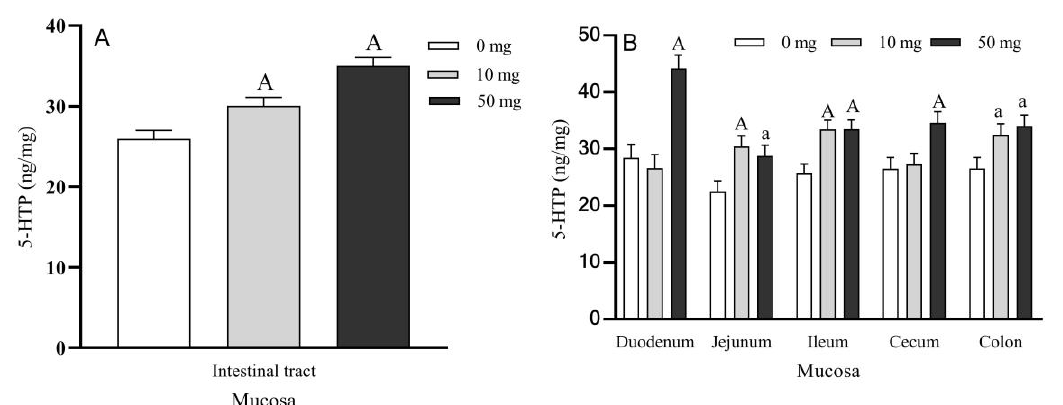
Figure 2. Effects of different doses of 5-HTP duodenal perfusion on 5-HTP content in sheep intestinal mucosa. ( A ) 5-HTP levels in general intestinal tract mucosa. ( B ) 5-HTP levels in the different intestinal segment mucosa. The data were expressed as LSM ± SEM ( n = 6). Small letters indicate p < 0.05, capital letters indicate p < 0.01 vs. their respective control groups.